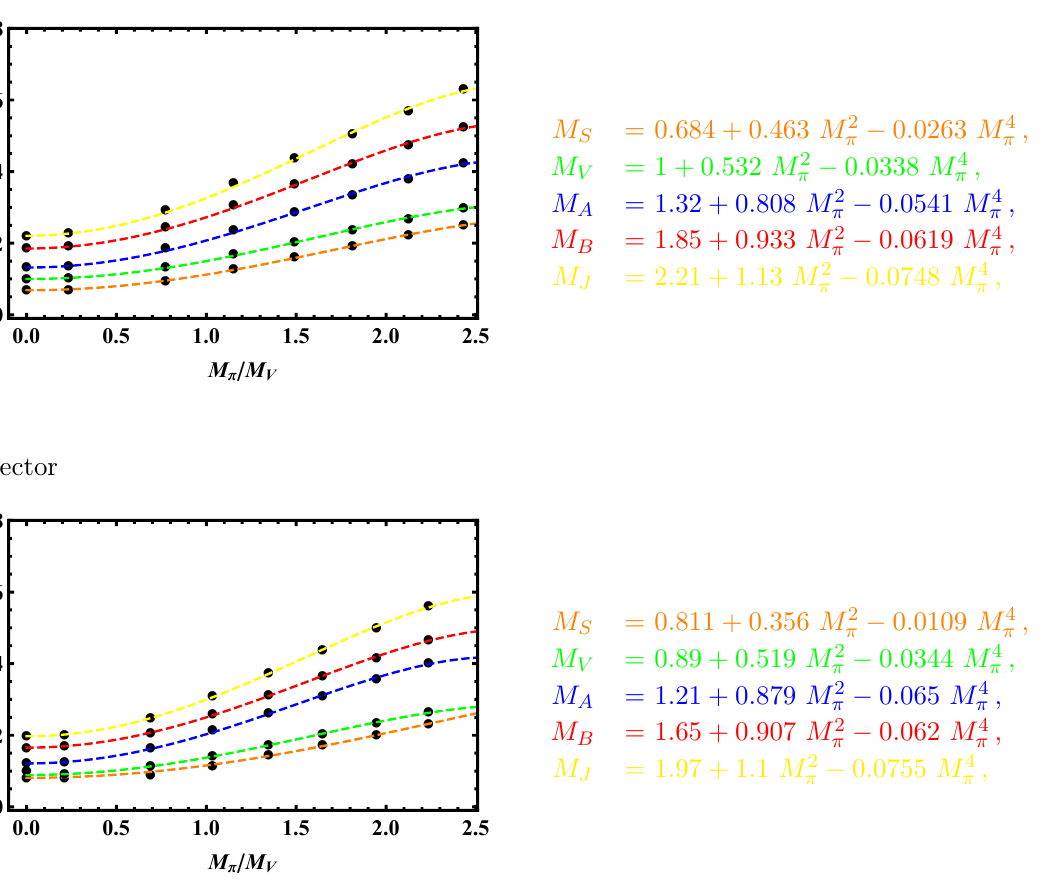
Figure 18. SU(4) 3 F, 3 ¯ F, 5 A 2 — The growth of the spectra as we increase the quark mass in the UV. The masses are rescaled with respect to the vector meson mass in the A 2 representation at m q | UV = 0 in accord with the presentation in table 5. In our analytic formulae the scale is again set by the A 2 vector meson mass at m q | UV = 0